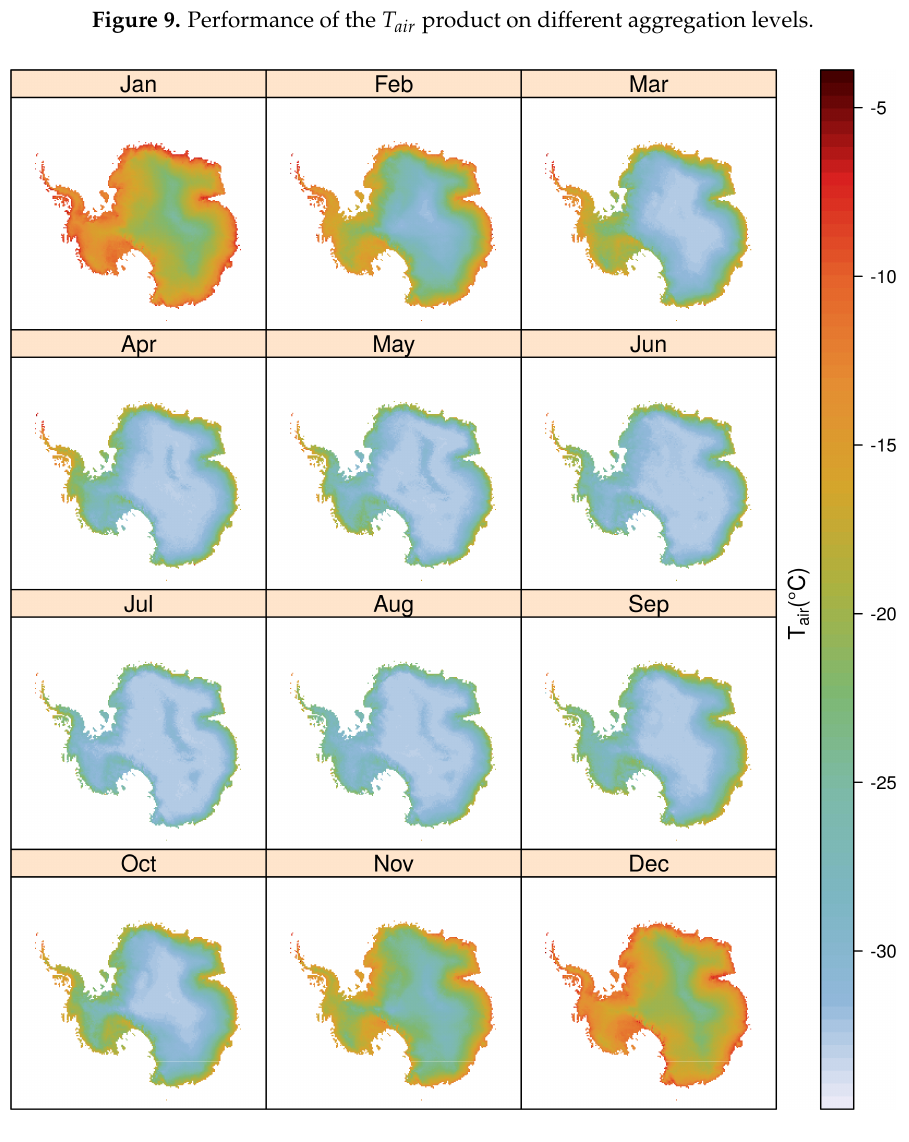
Figure 10. Monthly aggregates of T air as predicted by the GBM